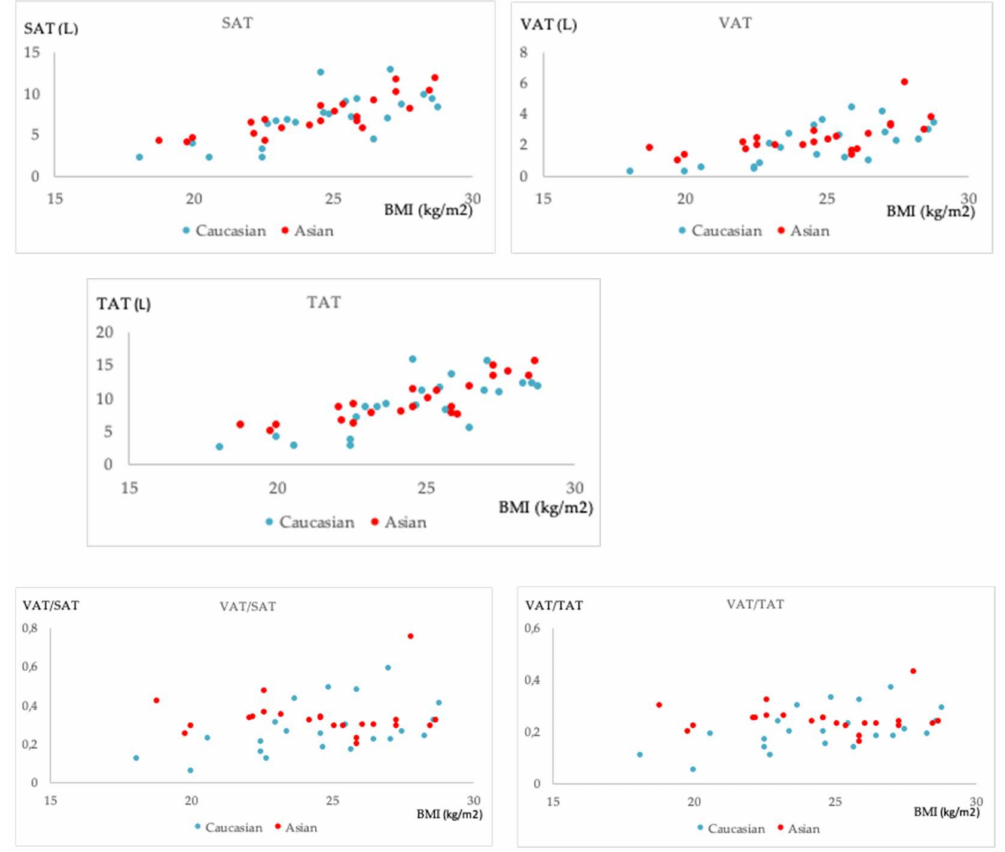
Figure 4. Scatter plots illustrating the relationships of fat measurements with BMI: SAT and VAT (top row: left to right), TAT (middle row) and VAT/SAT and VAT/TAT (bottom row: left to right) for the Caucasian (blue) and the Asian (red) group. Abbreviations: BMI: Body mass index; SAT: Subcutaneous adipose tissue; TAT: Total adipose tissue; VAT: Visceral adipose